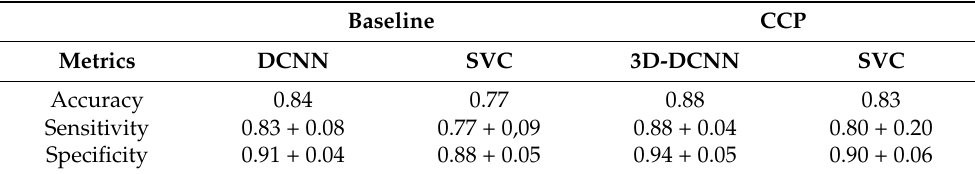
Table 4. Overall accuracy, sensitivity, and specificity of DCNN and SVC models on baseline im- ages classification, and of 3D-DCNN and SVC model in classification of the CCP images. Best performances are shown in